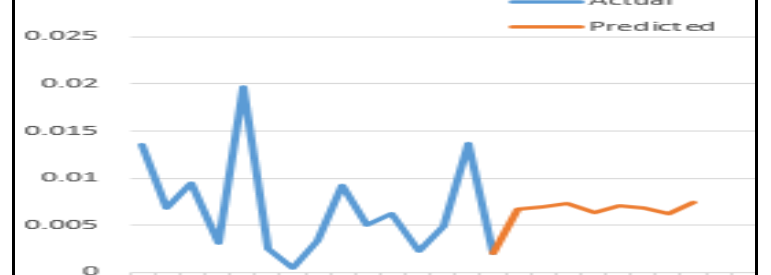
Figure.6. Short-term (5 days) Forecasting using NNAR